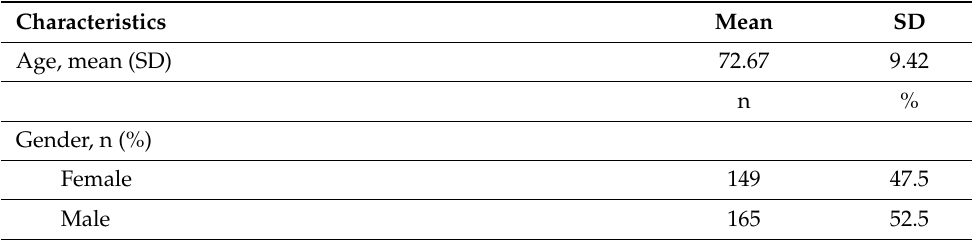
Table 1. General characteristics (n =